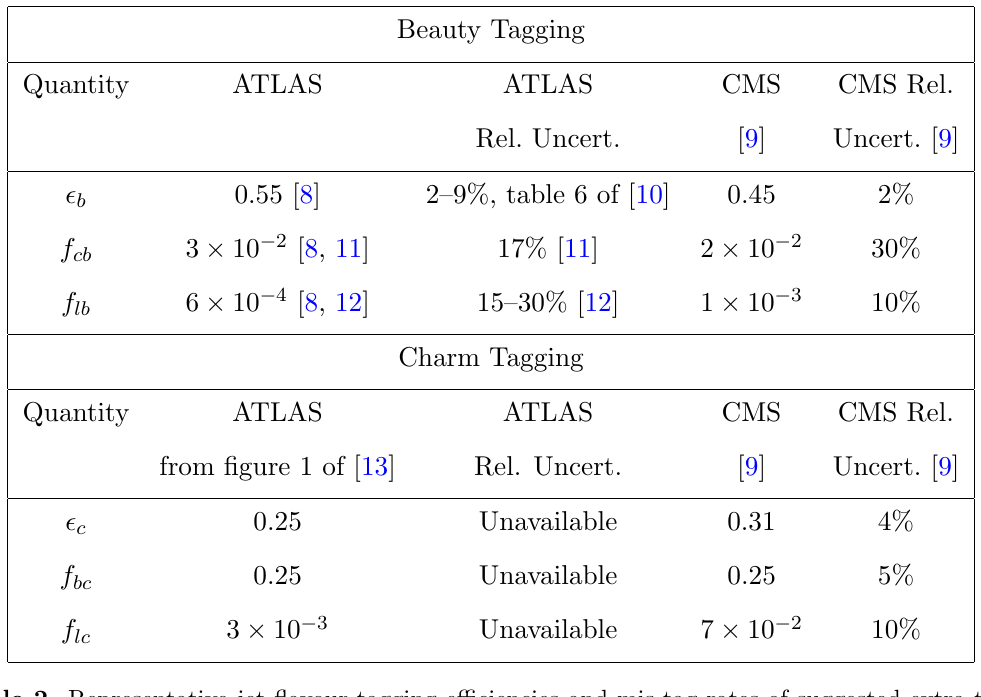
Table 2 . Representative jet (cid:13)avour-tagging e(cid:14)ciencies and mis-tag rates of suggested extra-tight \working points" selected from published ATLAS and CMS tagging performance ROC curves. The ATLAS b -tag values are taken from (cid:12)gure 10 of ref. [8]; the values of f cb and f lb have been modi(cid:12)ed according to the \scale factors" given in (the last bin of) (cid:12)gure 9 of [11] and from (cid:12)gure 13 of [12] respectively. The CMS values for (cid:15) b , f cb and f lb are taken from (cid:12)gures 16 and 17 of ref. [9] while the values for (cid:15) c , f bc and f lc are interpolated from (cid:12)gure 19. The CMS values are adjusted for the measured scale factors of (cid:12)gures 33 and 53 of ref. [9], from which the fractional uncertainties were also extracted. We note that the ATLAS fractional uncertainties (where available) do not necessarily correspond to the particular \working points" we suggest, but rather to the closest published values. The wide ranges of some are due to p T and other dependencies, where averaged values are not